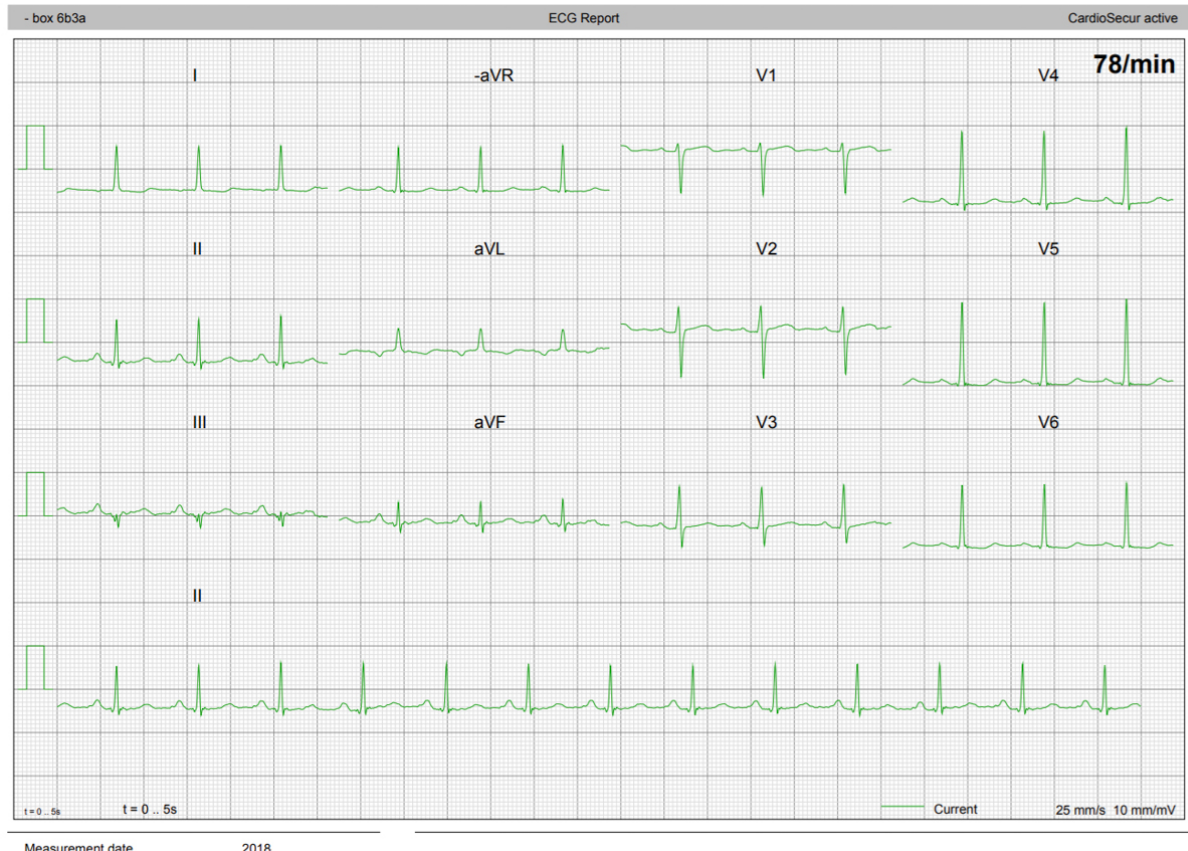
Figure 3. An electrocardiogram obtained with the CardioSecur